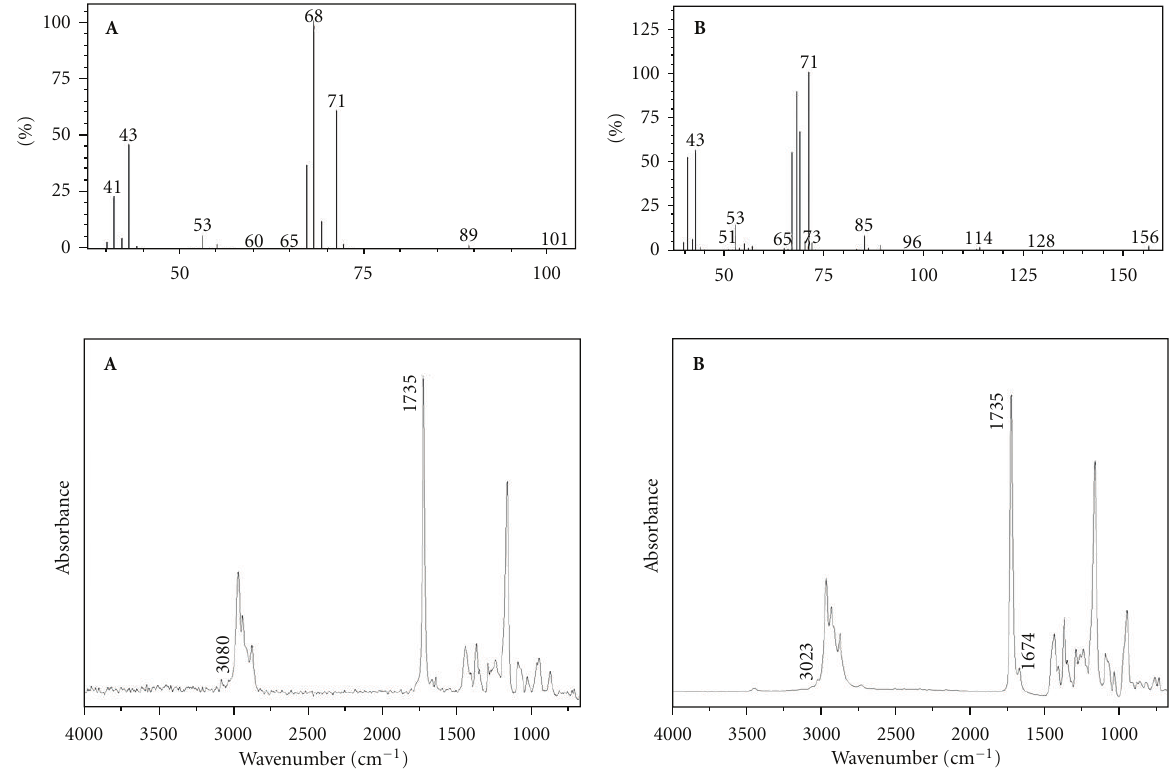
Figure 3: Mass and infrared spectra of the minor compound A and major compound B found in adults of Thaumastocoris peregrinus (Heteroptera: Thaumastocoridae). Extracts were analyzed on a Shimadzu GC MS-QP 2010 and GC-Fourier transform infrared spectroscopy